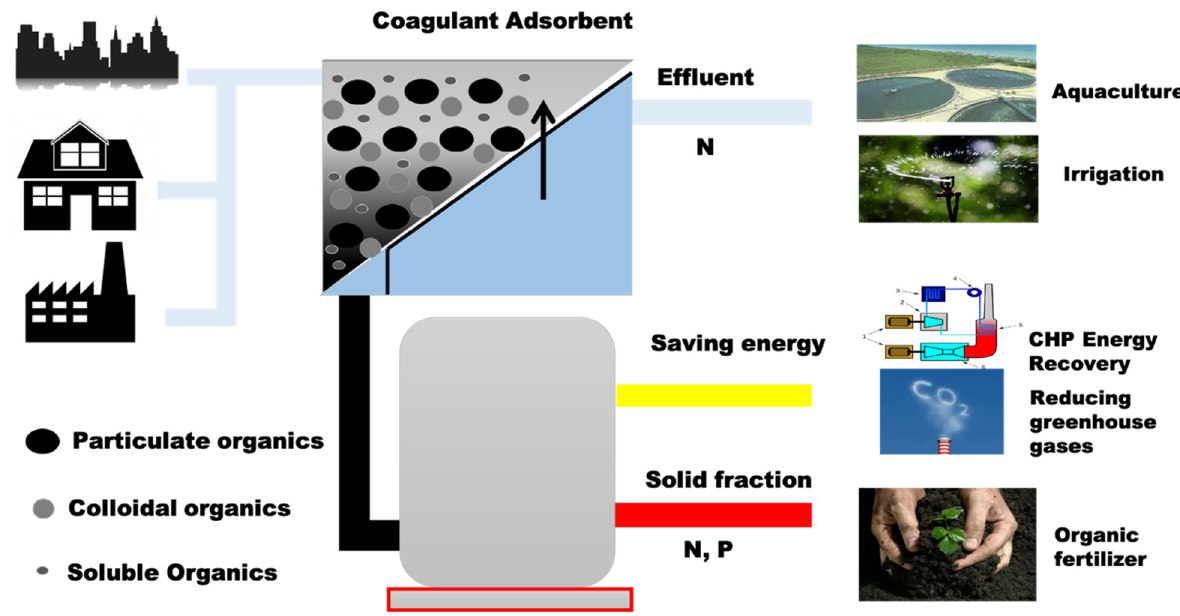
Figure 2. The outputs of treated wastewater, nutrients and sludge that are produced can be exploited to form an additional source of income.